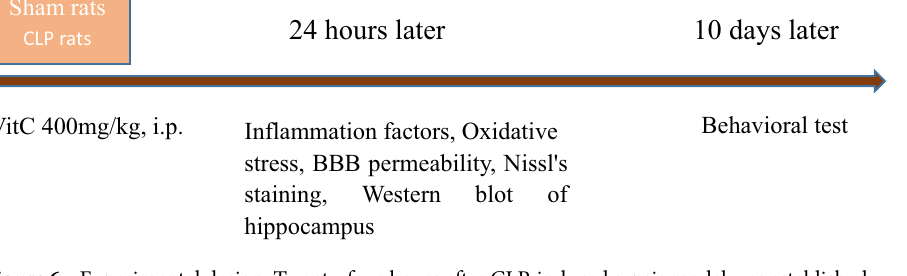
Figure 6. Experimental design. Twenty-four hours after CLP-induced sepsis model was established, inflammatory factors, oxidative stress of Serum and hippocampus, BBB permeability, Nissl’s staining of hippocampus, and Western blot of hippocampus were evaluated. Ten days after CLP-induced sepsis model, behavioral tests of rats were